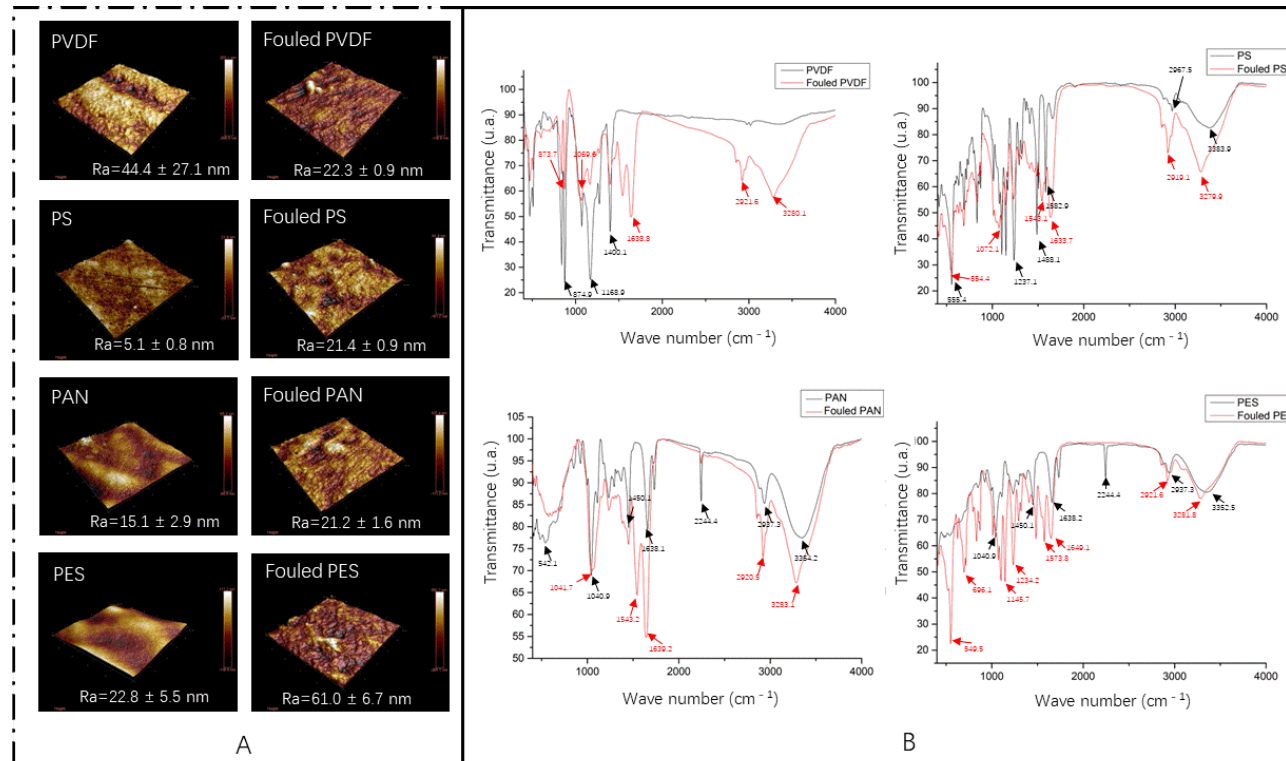
Figure 5. AFM images: ( A ) Clean membranes and fouled membranes. FTIR spectra: ( B ) Clean membranes and fouled membranes.